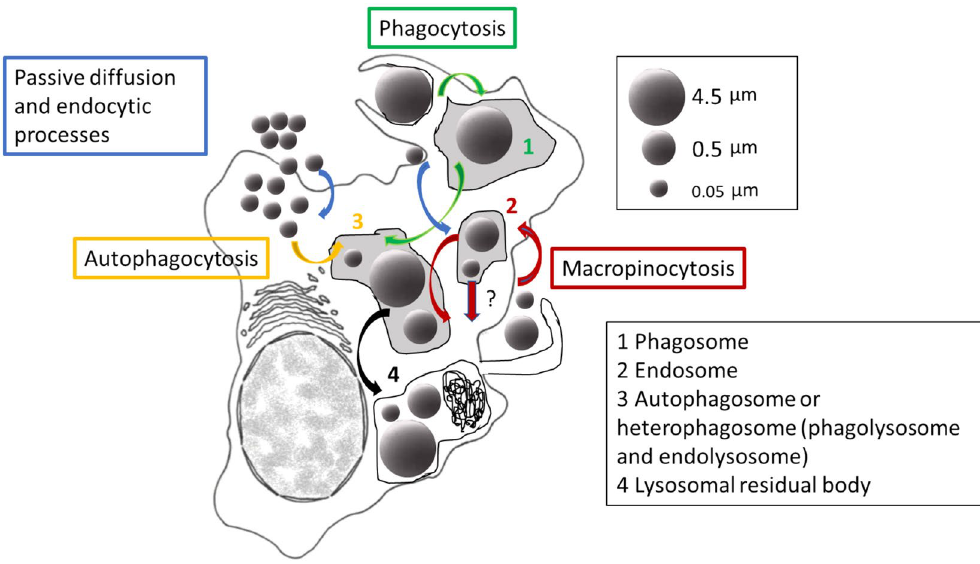
Figure 9. Simplified schematic diagram of a model for uptake and trafficking of PS NPs and MPs in mussel hemocytes. NPs formed large aggregates in the BME culture medium but were internalized and found in the cytosol and inside membrane-bound vesicles, indicating possible entrance by passive diffusion and endocytic processes, respectively. Also, it could be that NPs found in the cytosol escaped from the endo-lysosomal system after internalization (?). MPs of 0.5 μm were found extracellularly surrounded by cytoplasmic projections and intracellularly within membrane-bound vesicles suggesting internalization via macropinocytosis although other endocytic pathways could also be involved. NPs and MPs of 0.5 μm could reach the endosomes and endolysosomes. Finally, MPs of 4.5 μm appeared to enter in the hemocytes by phagocytosis and were found inside vesicles resembling phagosomes or phagolysosomes. Both by autophagic or heterophagic pathways, the final fate of NPs and MPs could be large tertiary lysosomes or residual bodies containing lipofuscins, which were more abundant than in control cells. It could be that these residual bodies were exocytosed from the cells at a later